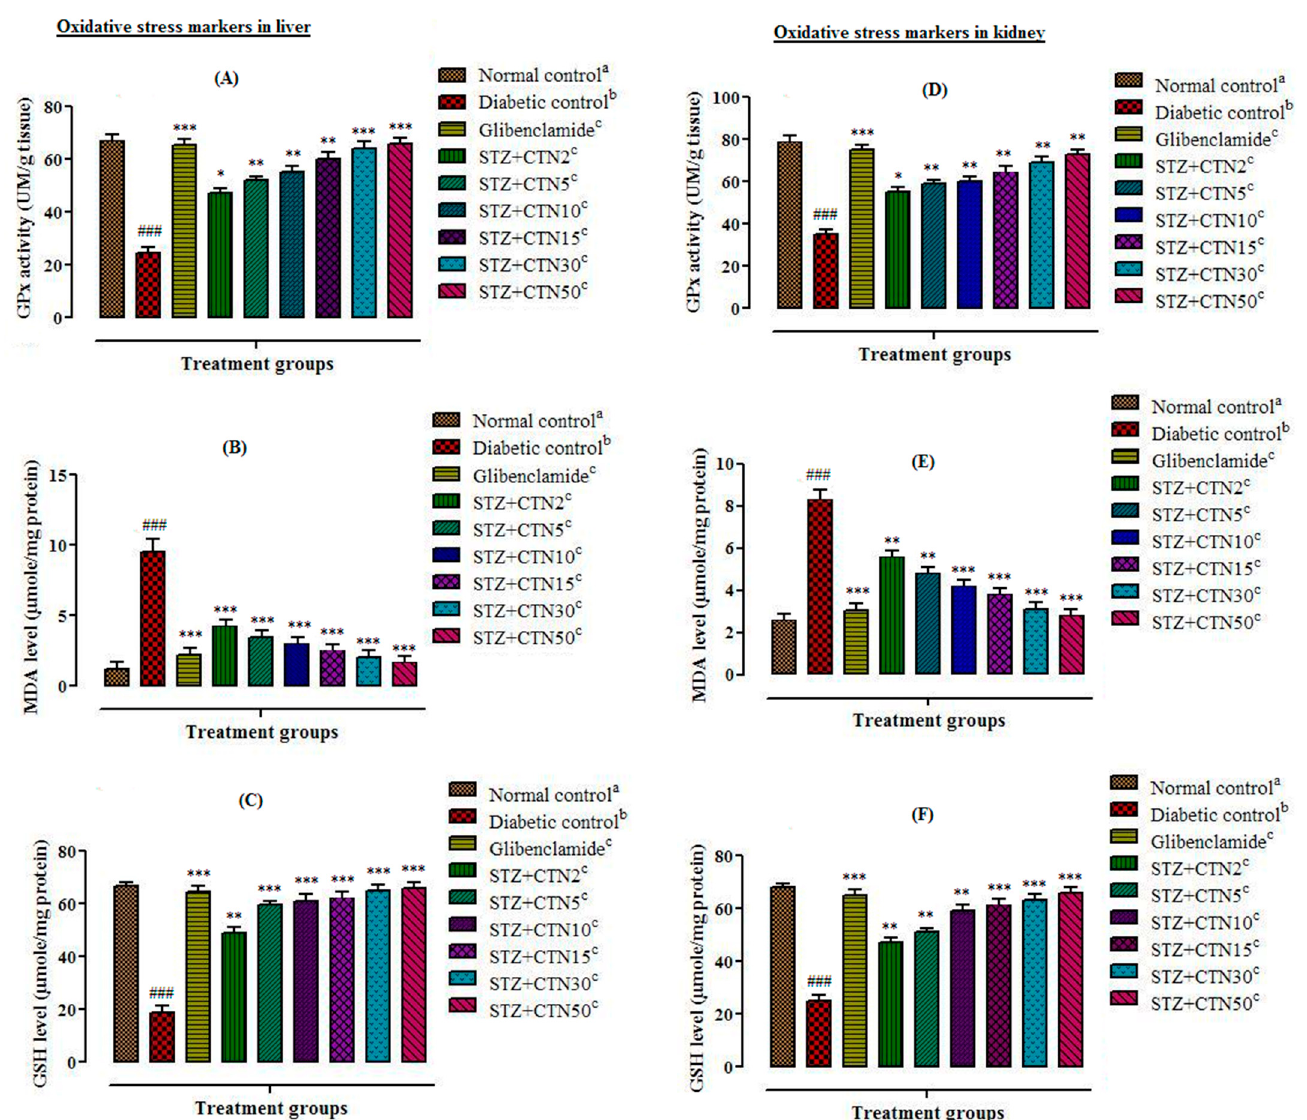
Figure 5. Effects of catechin (2, 5, 10, 15, 30, and 50 mg/kg) and glibenclamide (5 mg/kg) on liver and kidney oxidative stress markers in diabetic rat in STZ-induced diabetic rats. Oxidative stress markers in liver: ( A ) GPx, ( B ) malondialdehyde (MDA) ( C ) glutathione (GSH). In kidney: ( D ) GPx, ( E ) MDA, ( F ) GSH. The values are expressed as mean ± SEM. Each value corresponds to a mean of eight animals ### p ˂ 0.001; comparison of a (normal control) vs. b (diabetic control) using student t-test , * p ˂ 0.05, ** p ˂ 0.01, *** p < 0.001; comparison of b (diabetic control) vs. c (Glibenclamide and CTN treated groups) using one way ANOVA followed by Dunnett’s post hoc multiple comparison test.